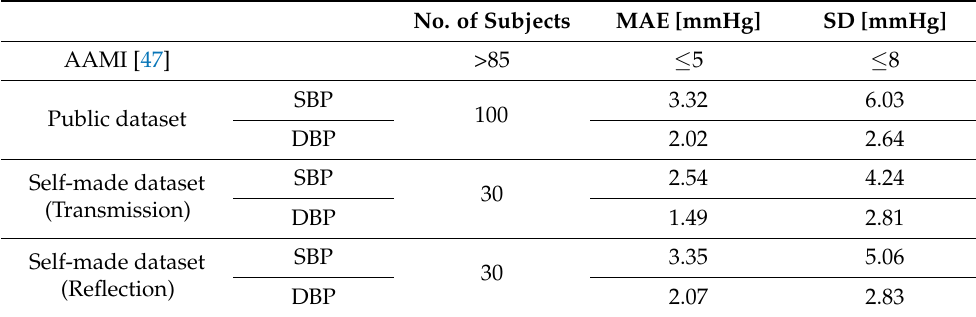
Table 12. Comparison of our results with the AAMI standard.